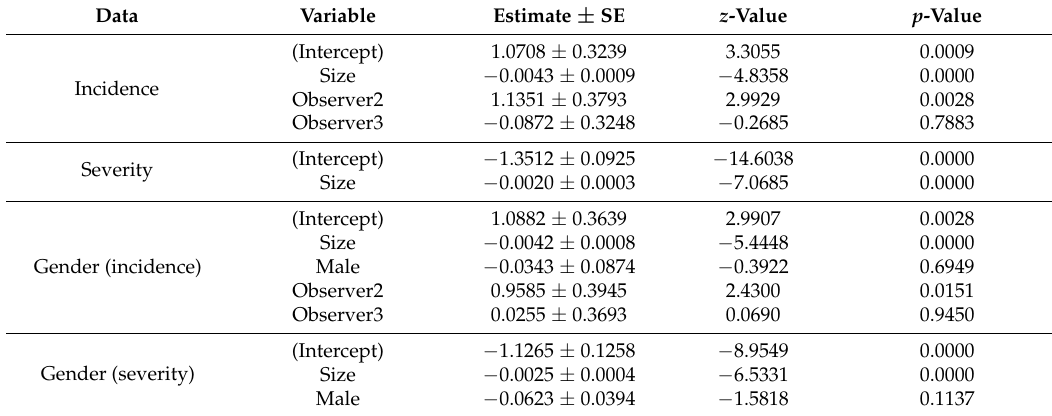
Table 2. Model coefficients for the best fitting models describing the relationship between injury incidence and severity with size, whilst accounting for the variability between the reefs in all models and observer bias for models of incidence (Figures 5 and